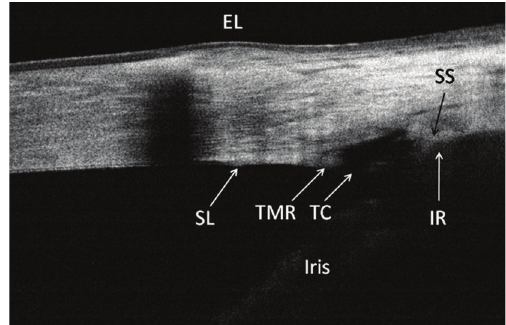
Figure 6: A cross-sectional OCT image of the nasal angle following trabectome surgery. This frame-averaged image shows that the posterior trabecular meshwork has been removed, leaving a 374 µ m wide trabecular cleft (TC) and an anterior trabecular meshwork remnant (TMR). Although scleral shadowing has caused the iris root (IR) to appear indistinct, it was possible to trace its position by contiguity with the iris. The limbal girdle of Vogt is the cause of the shadowing in the peripheral cornea. (Courtesy of